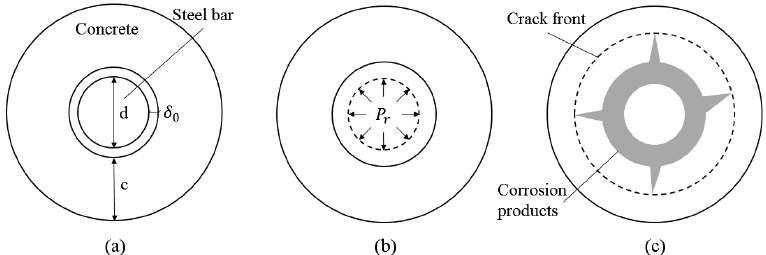
Figure 1. Schematic diagram of corrosion-induced concrete cracking process: ( a ) initial unrestrained reinforced concrete; ( b ) internal expansive pressure for concrete in restrained condition; ( c ) corrosion products deposited within open cracks.